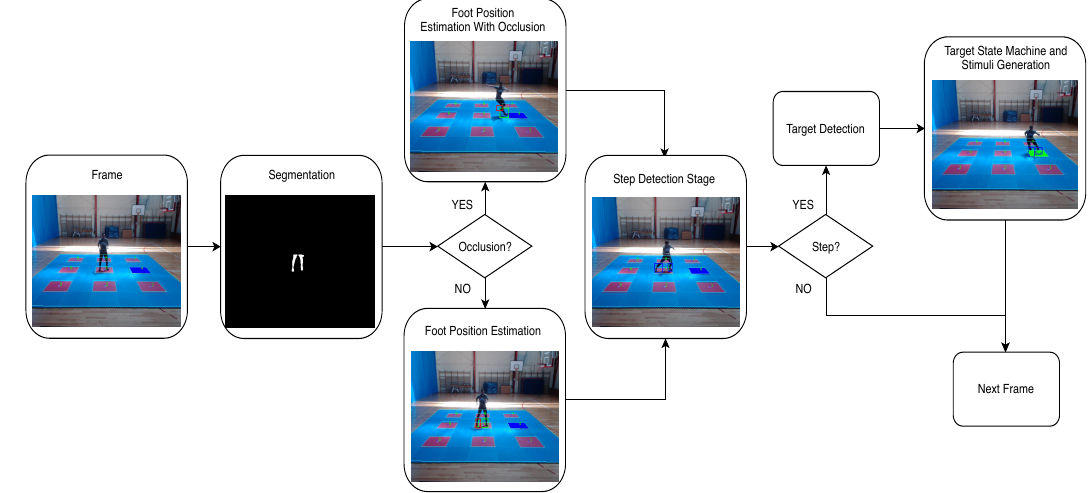
Figure 5. Algorithm stages